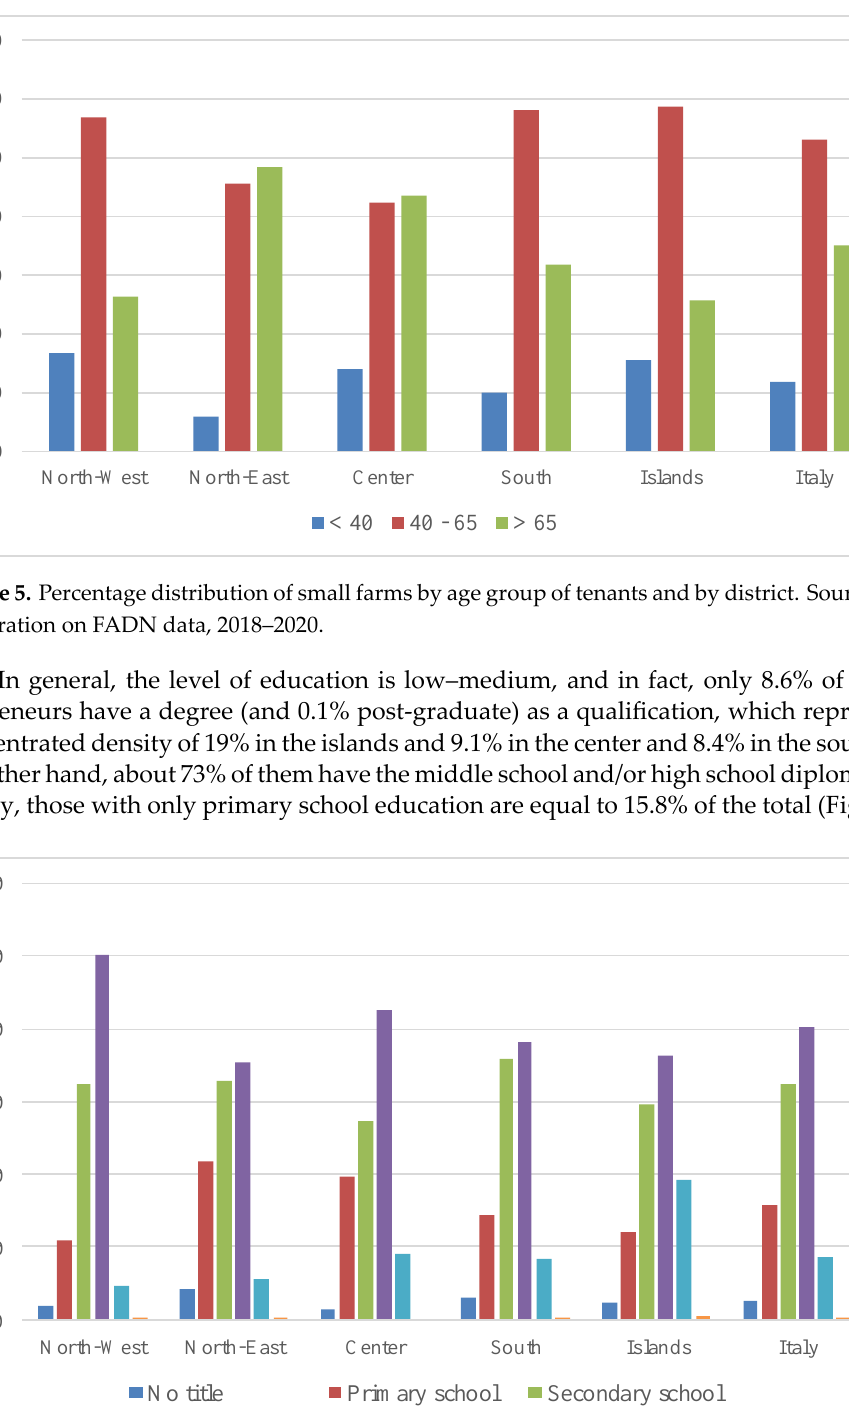
Figure 7. Economic indices of small farms by utilized agricultural area (UAA) and by district. Source: Our elaboration on FADN data, 2018 – 2020. The district with the highest average value of the index is the north-west with a net income per hectare of UAA of just over EUR 6200 per hectare. This is followed by the north-east district, where the index assumes an average value of approximately EUR 3800/ha. In the south, with just EUR 1265/ha, the worst performance is recorded. If we go into regional detail (Figure 8), we note that the best performances of the small farms are found in the northern regions, where the values of Trentino Alto Adige stand out, with over EUR 17,000 /ha, and that of the Valle D ’ Aosta with more than EUR 10,000/ha. On the contrary, the southern regions show much lower results, and this is par- ticularly true for the regions of Basilicata, which record the lowest value of profitability per hectare (EUR 738), Molise (EUR 913/ha) and Calabria (EUR 968/ha).